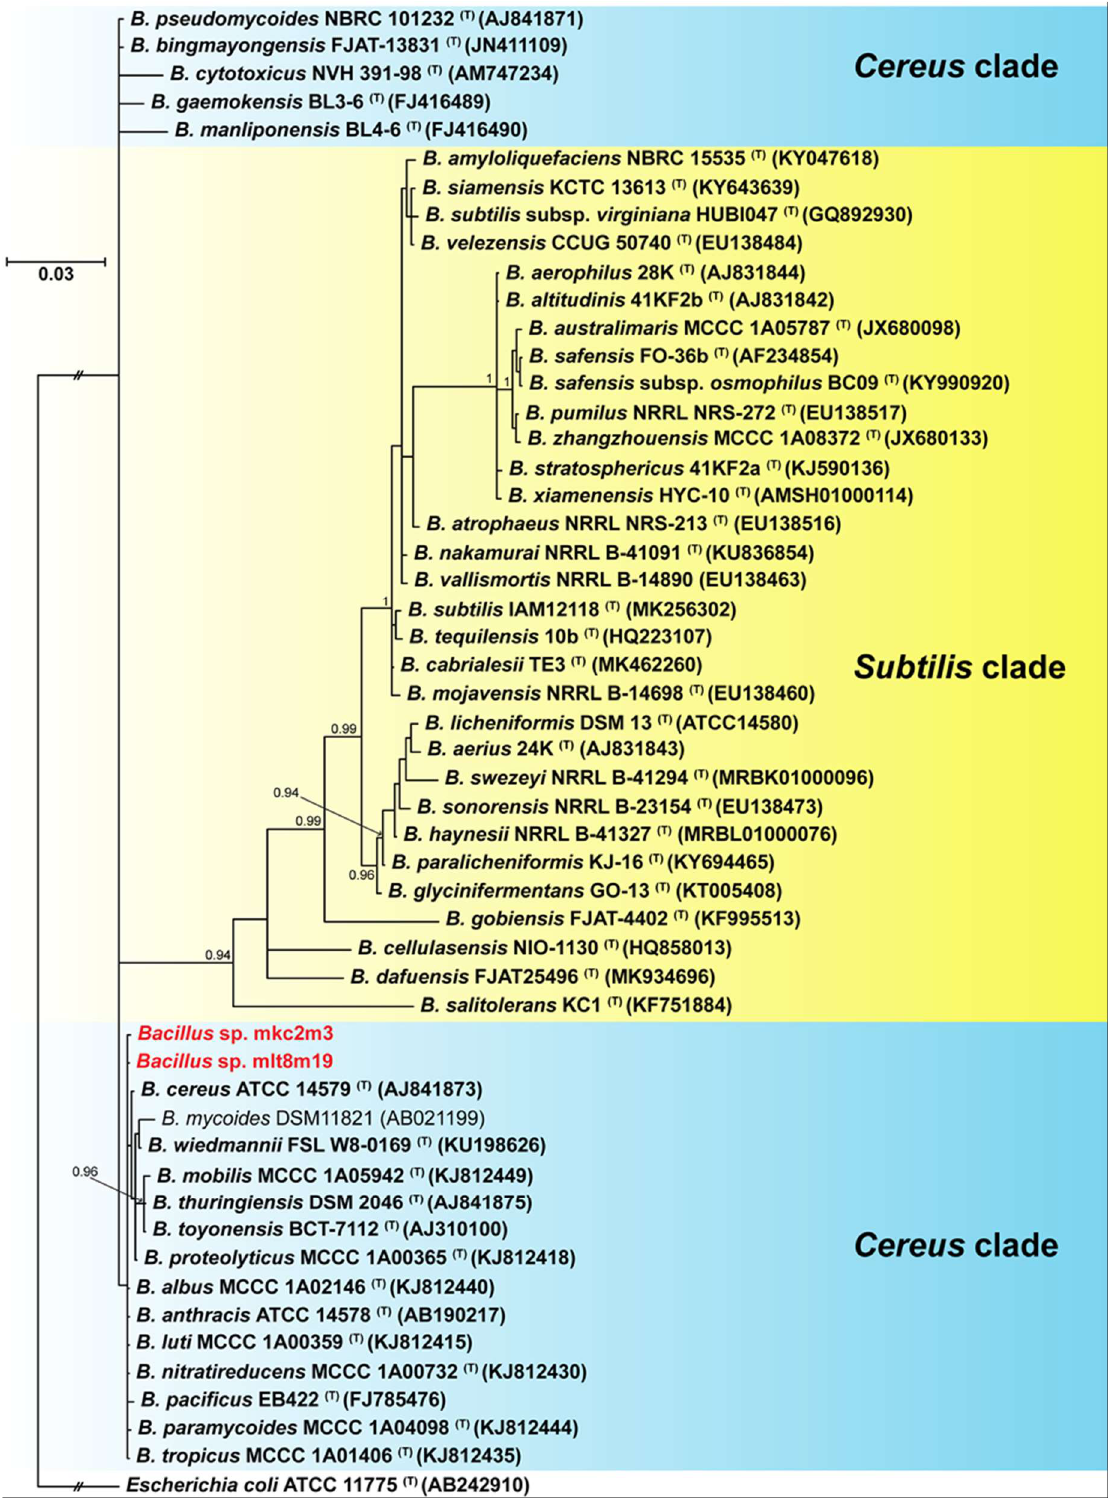
Figure 4. Bayesian inference phylogenetic tree of MKC2M3 and MLT8M19 isolates and all accepted species of Bacillus based on the 16S rDNA sequences. The species Escherichia coli (ATCC11775) was used as outgroup. Strains marked with a “T” and emphasized in bold correspond to sequences from type-strains. The scale bar of 0.03 represents the number of changes per site. MLsh-ALRT, ultrafast bootstrap values, and posterior probability support values are presented on the left side of nodes.